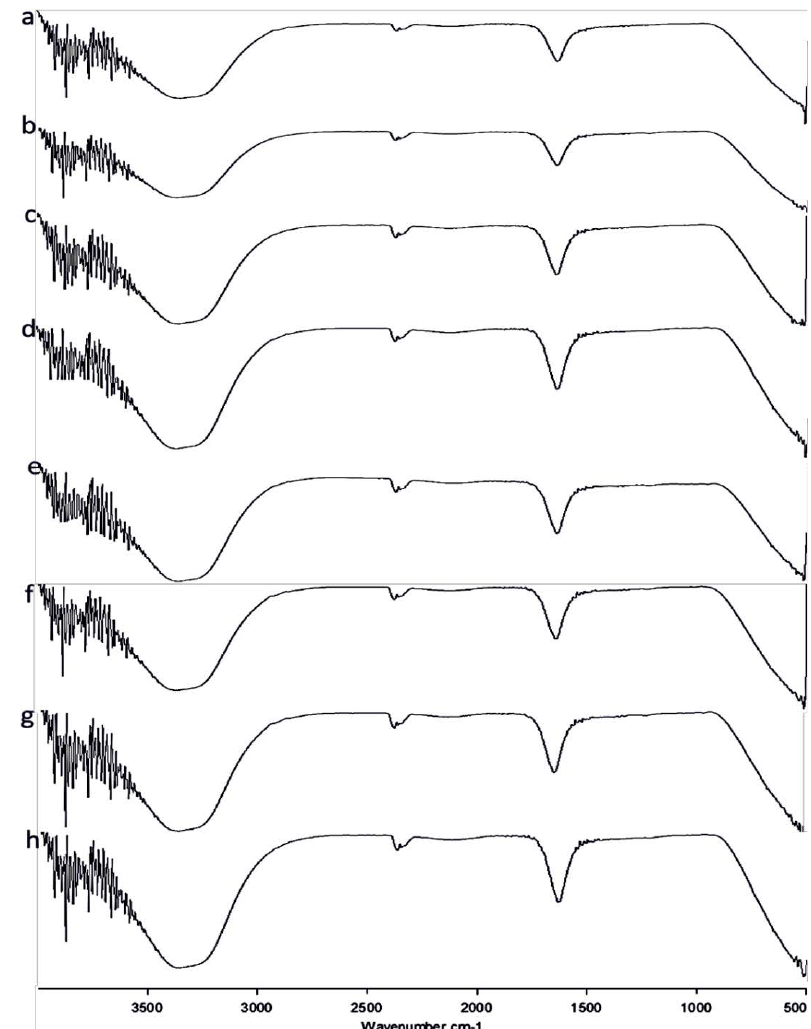
Fig. 5. FT-IR of Pyocyanin extracted (a) Control, (b) Punica granatum, (c) Citrus reticulata, (d) Vitis amurensis, (e) Carica papaya, (f) Vitis vinifera, (g) Ananas comosus, (h) Ficus